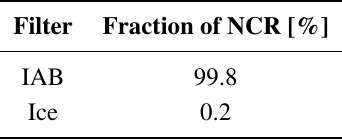
Table 2. Percentage of removed NCR data for each of the applied filter in the listed order.